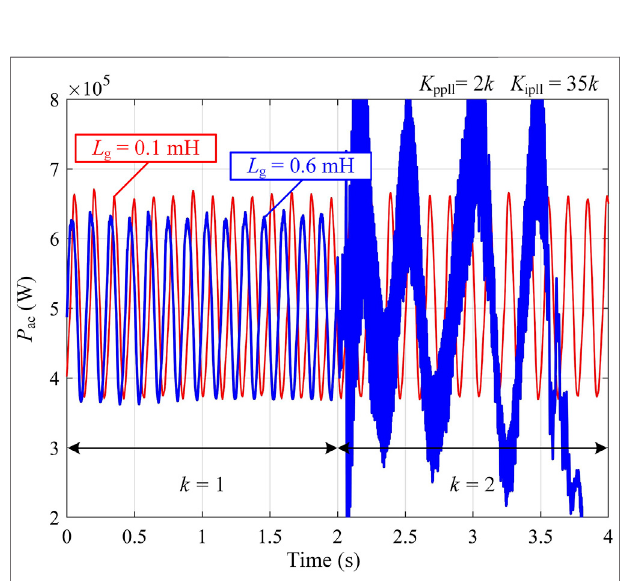
FIGURE 11 | Power output when changing L g and PLL